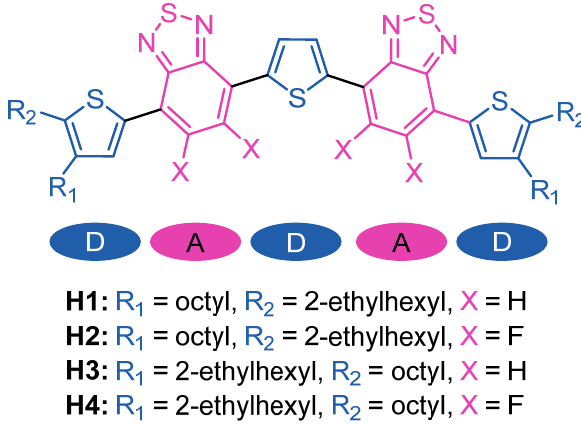
Figure 1. Molecular structures of designed H1-4 molecules.